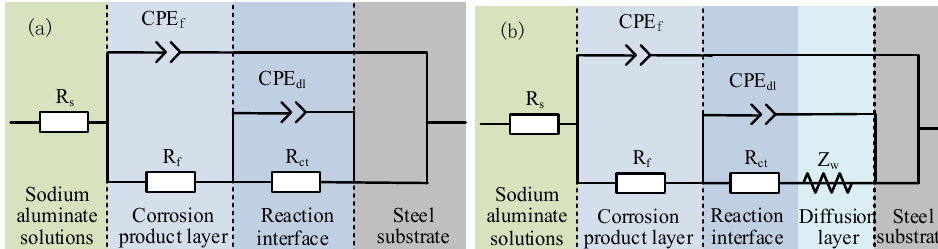
Figure 9. Equivalent circuit for EIS of Q235 steels with different corrosion times. ( a ) 1d, 2d, 4d, 5d; and ( b ) 3d. Table 4. Impedance parameters obtained on Q235 steels with different corrosion times.